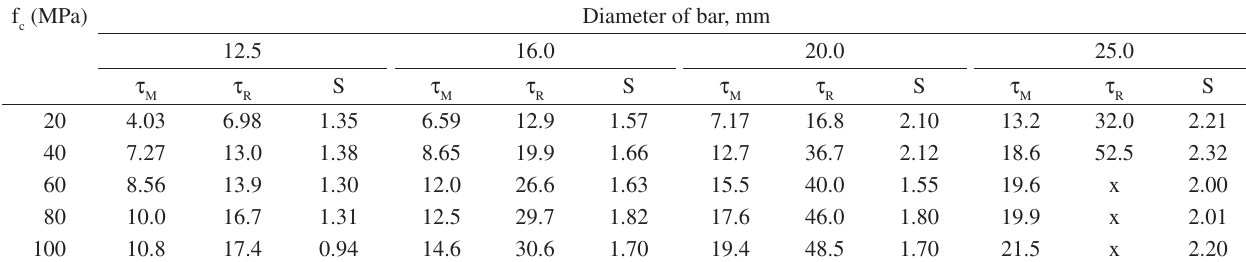
Table 5. Medium bond stress, rupture bond stress (MPa) and maximum slipping (mm) in the pull out test.